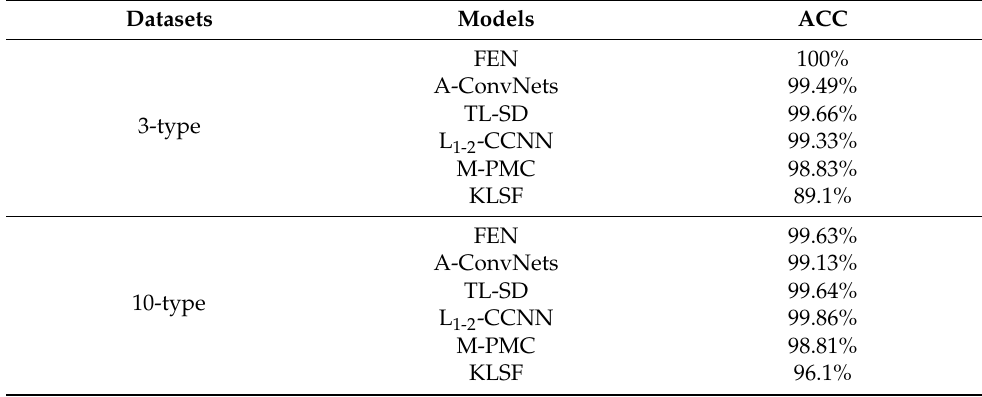
Table 4. The test accuracy of FEN, A-ConvNets, TL-SD, L 1-2 -CCNN, M-PMC and KLSF.